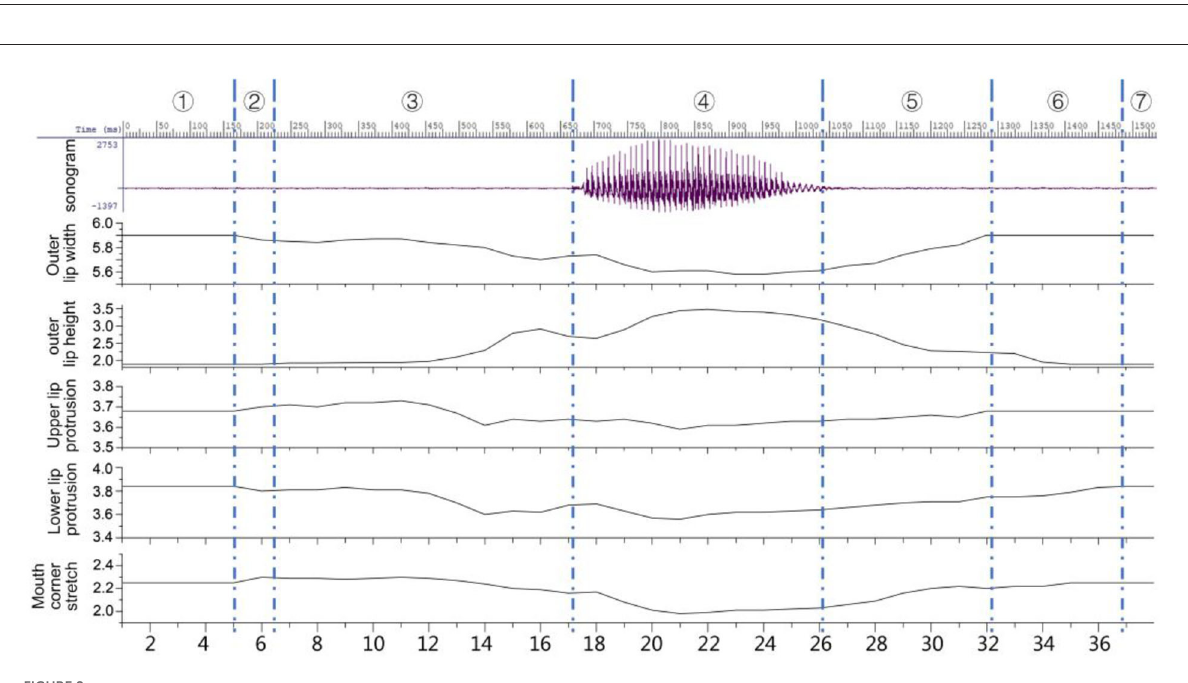
FIGURE8 The sonogram and parameter change of lip shape of Tibetan “ ”.